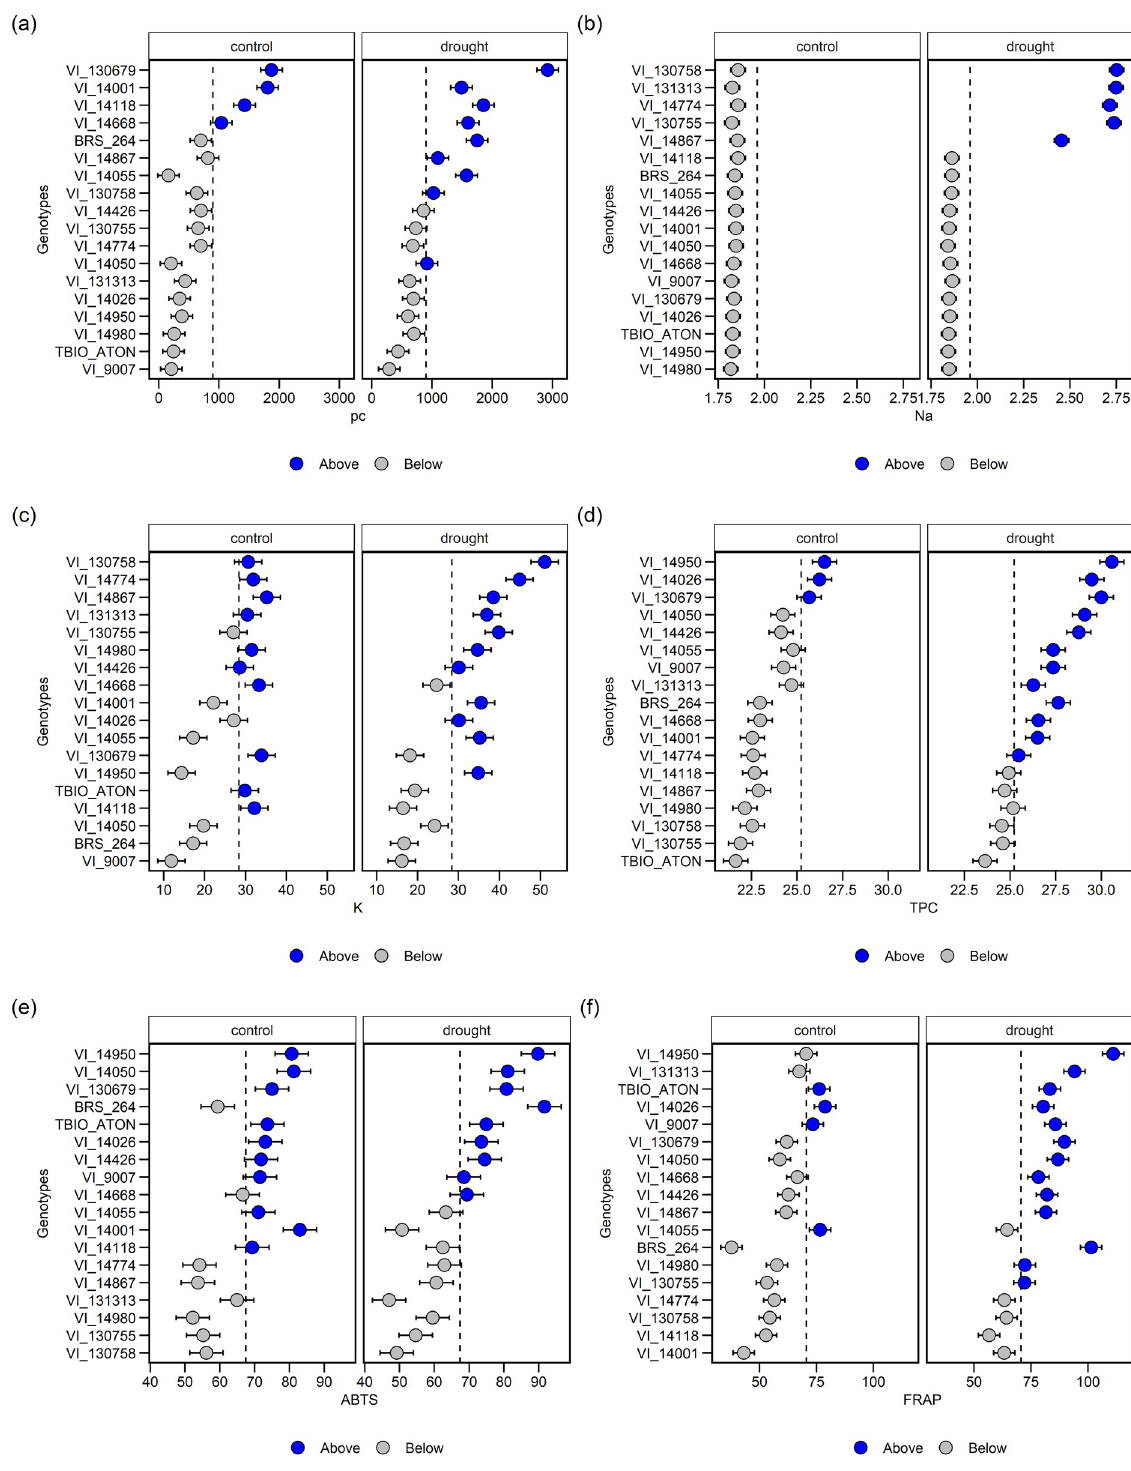
Fig 3. Results of BLUP values for 18 genotypes of wheat evaluated under two conditions (control and stress), for the variables proline content (pc, μ g g -1 ) (a), sodium (Na, mg g -1 ) (b), potassium (K, mg g -1 ) (c), total phenolic compounds (TPC, mg GAE g -1 ) (d), antioxidant activity by ABTS (mM TEAC g -1 ) (e) and FRAP (mM Fe +2 g -1 ) (f).